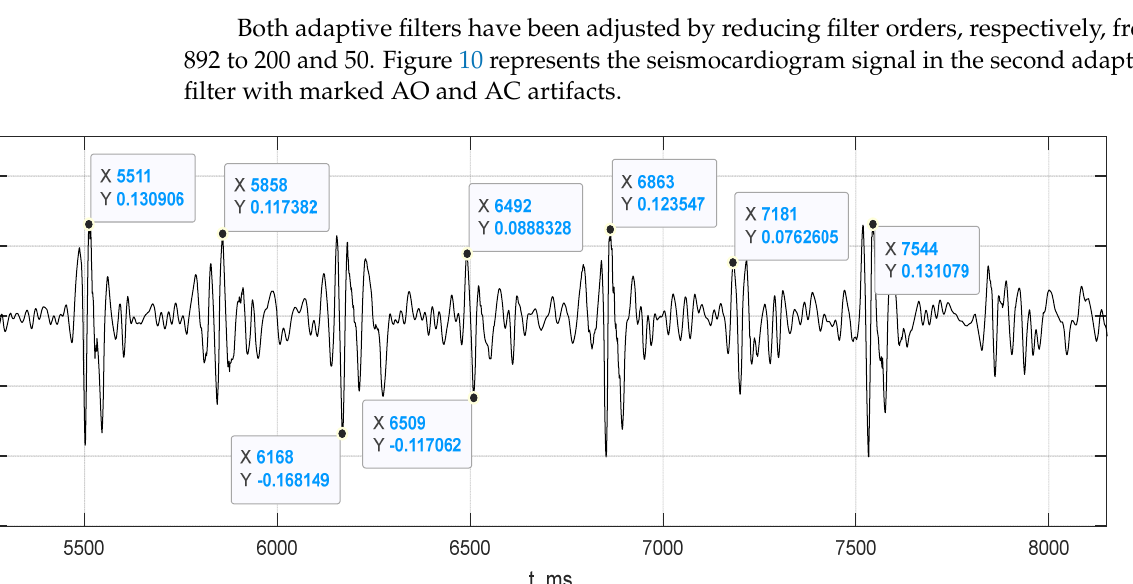
Table 6. Rest SCG signal processing data with individually adjusted adaptive filters.